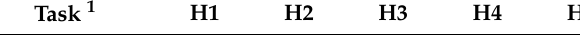
Table 17. PPA table for tasks in Hilbert transforms.